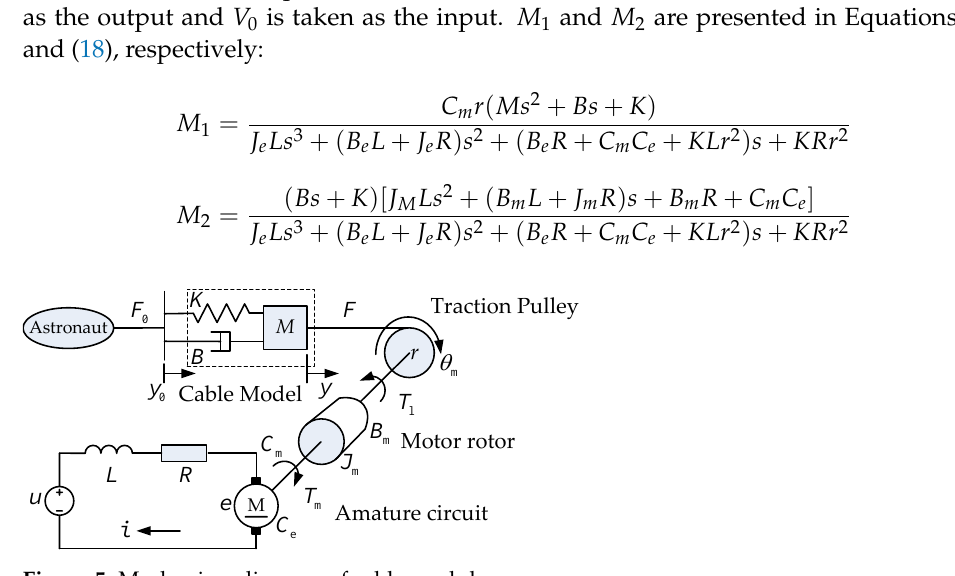
Figure 5. Mechanism diagram of cable module.